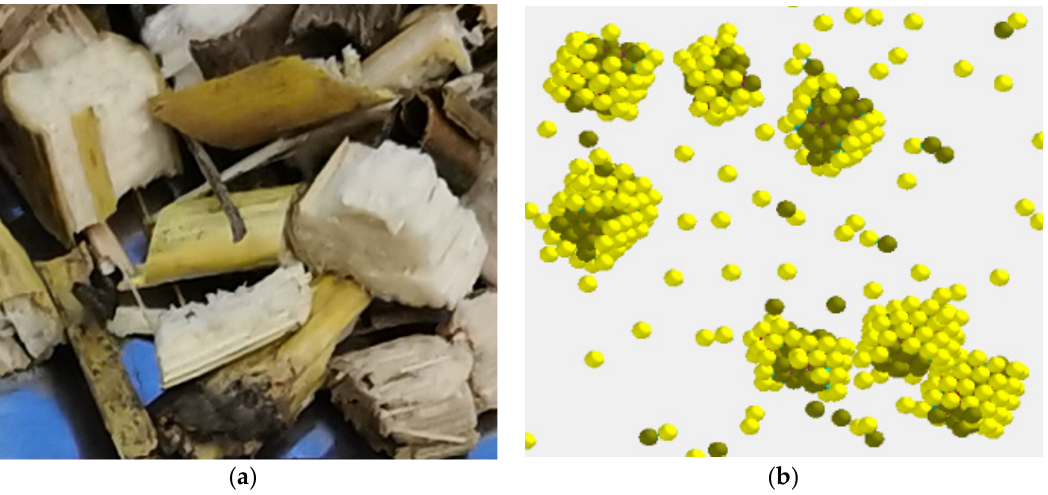
Figure 18. Comparison of shredded sections of corn straw. ( a ) Actual shredded section of corn straw; ( b ) simulated shredded section of corn straw. Table 13. Test comparison and results.